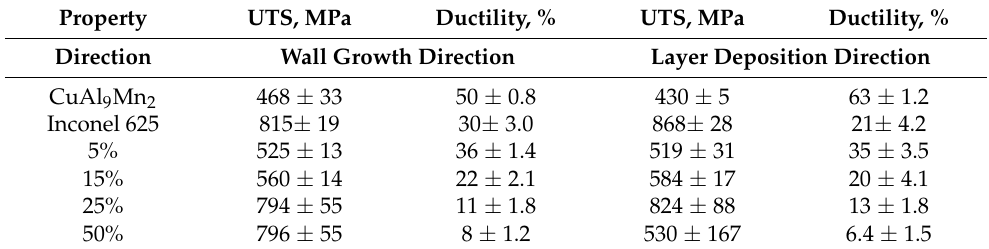
Table 1. Tensile test results for multimaterials and initial materials. Property